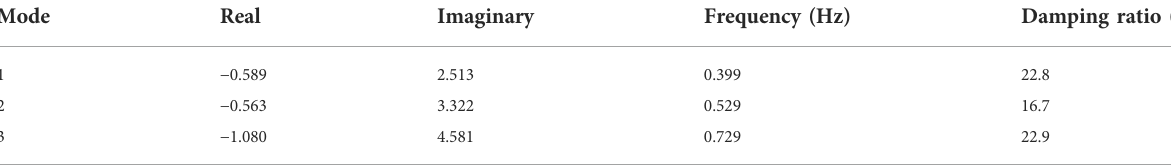
TABLE 2 The characteristic results of simpli fi ed 14-generator